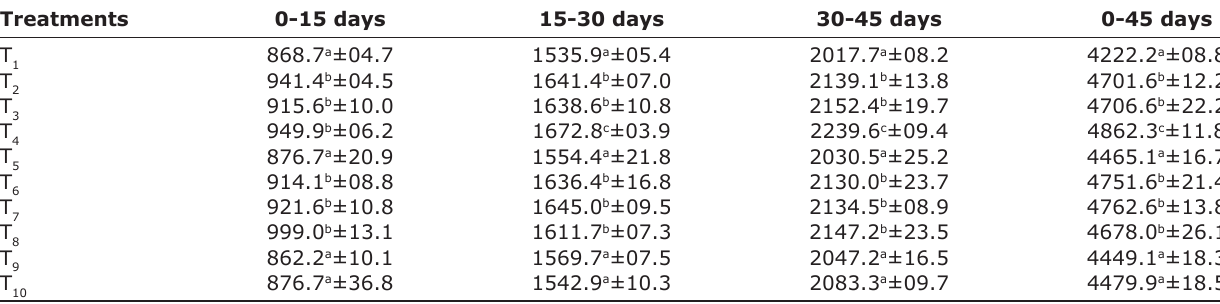
Table-5: Feed intakes (g/bird) during different growth periods under different dietary treatments. Treatments